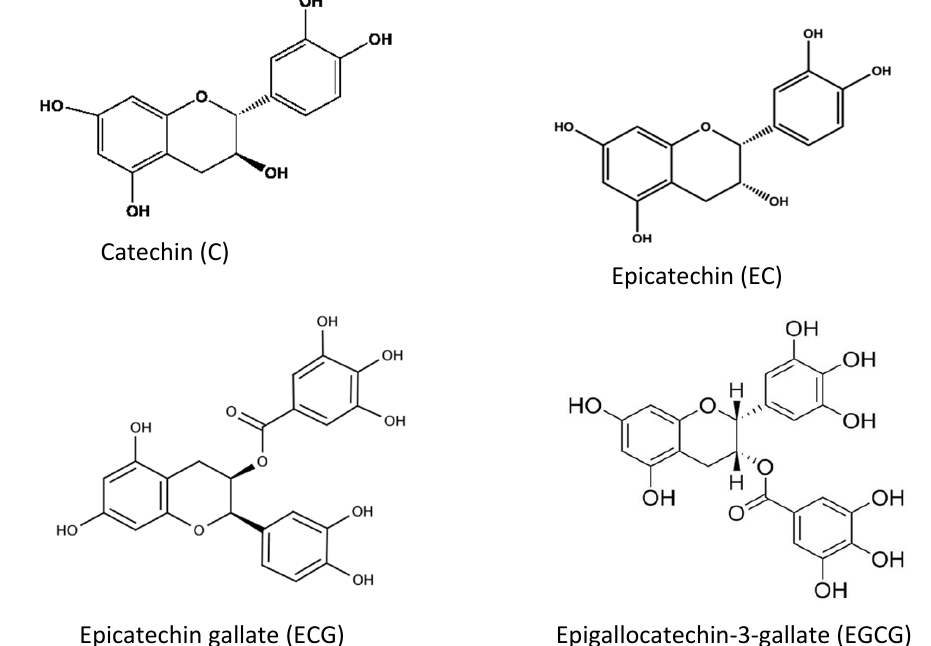
Figure 9. Different chemical structures of catechins found in green tea. Chlorogenic acids and their derivatives, including caffeoylquinic acids,